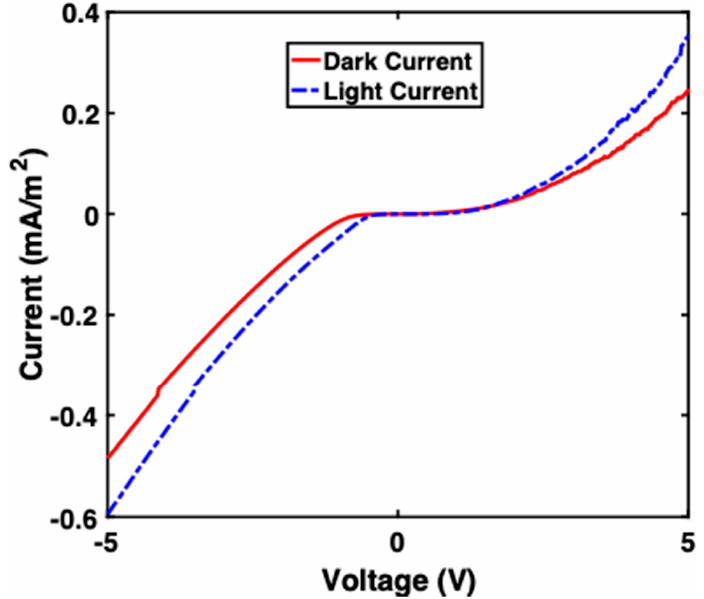
Figure 5 Figure 5. I-V profile of sample B (the sample with an oxide layer)